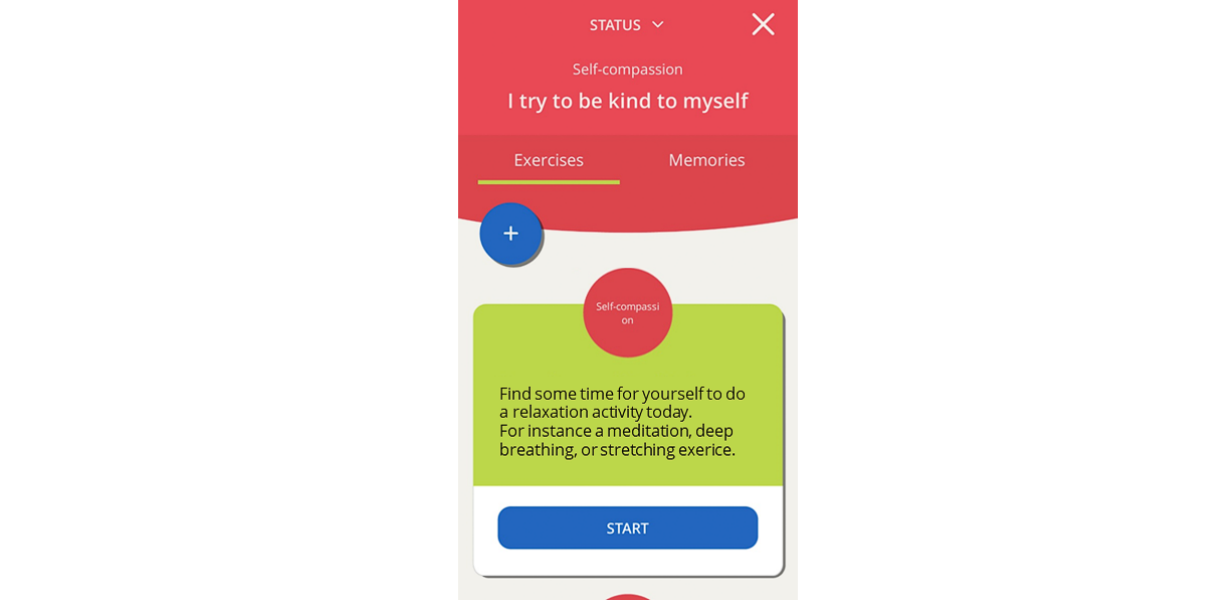
Figure 13. Rating the day in the daily